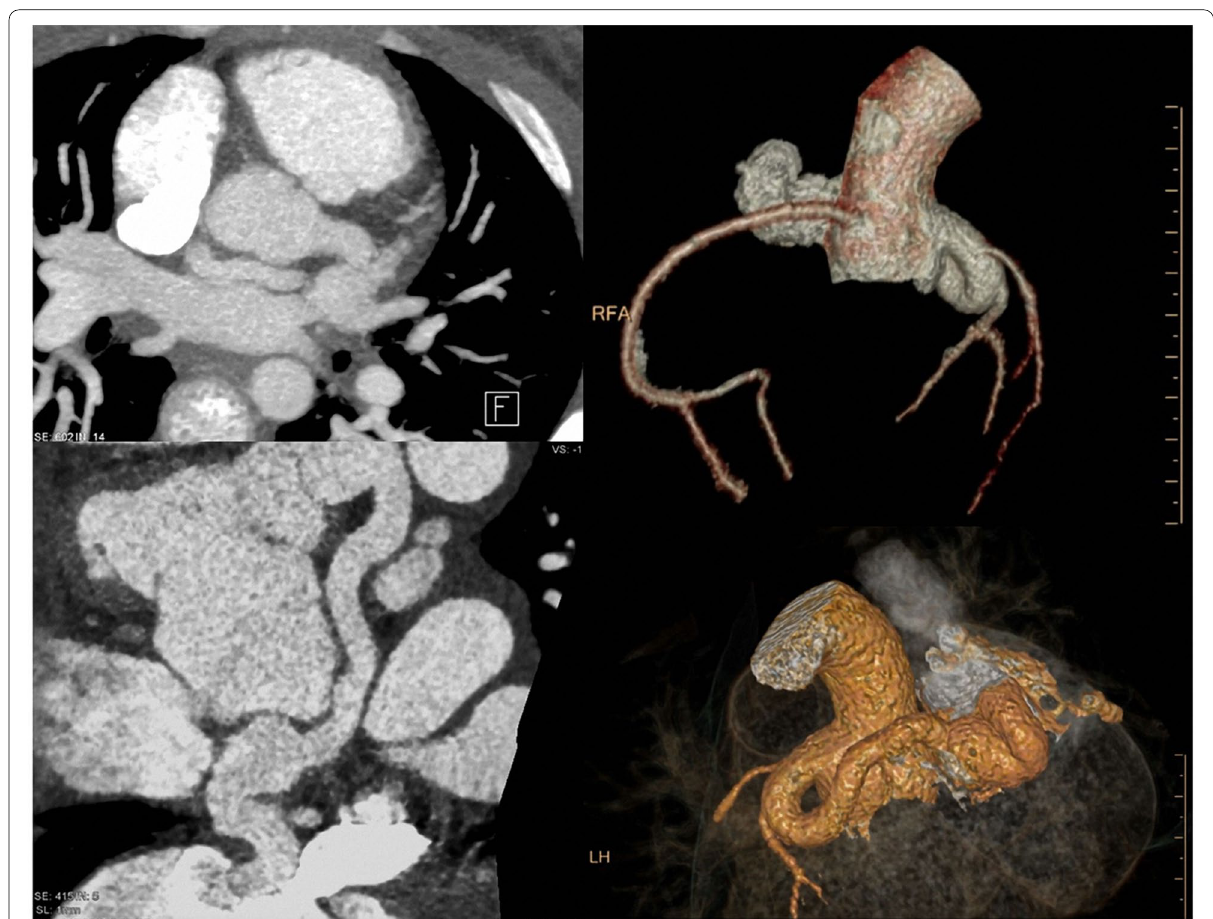
Fig. 13 (Planning, dose monitoring (left upper and lower row), axial and paracoronar 2D MIP reconstructions (middle), and 3D VRT reconstructions (right)): 11-year-old girl. Previous surgical repair of a VSD. Now suspected (echocardiography—not shown) coronary fistula. CTCA with dose